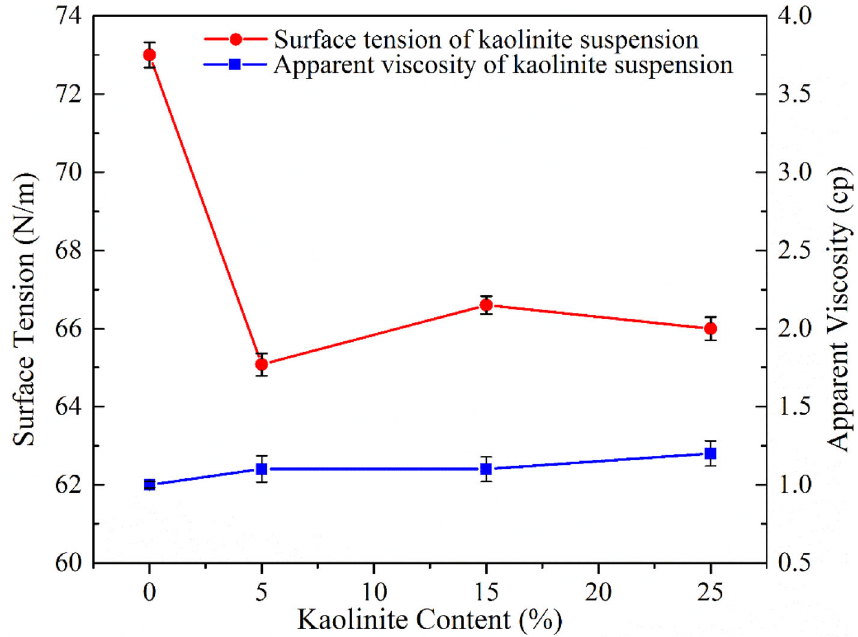
Fig. 7 Surface tension and apparent viscosity of kaolinite suspension with different